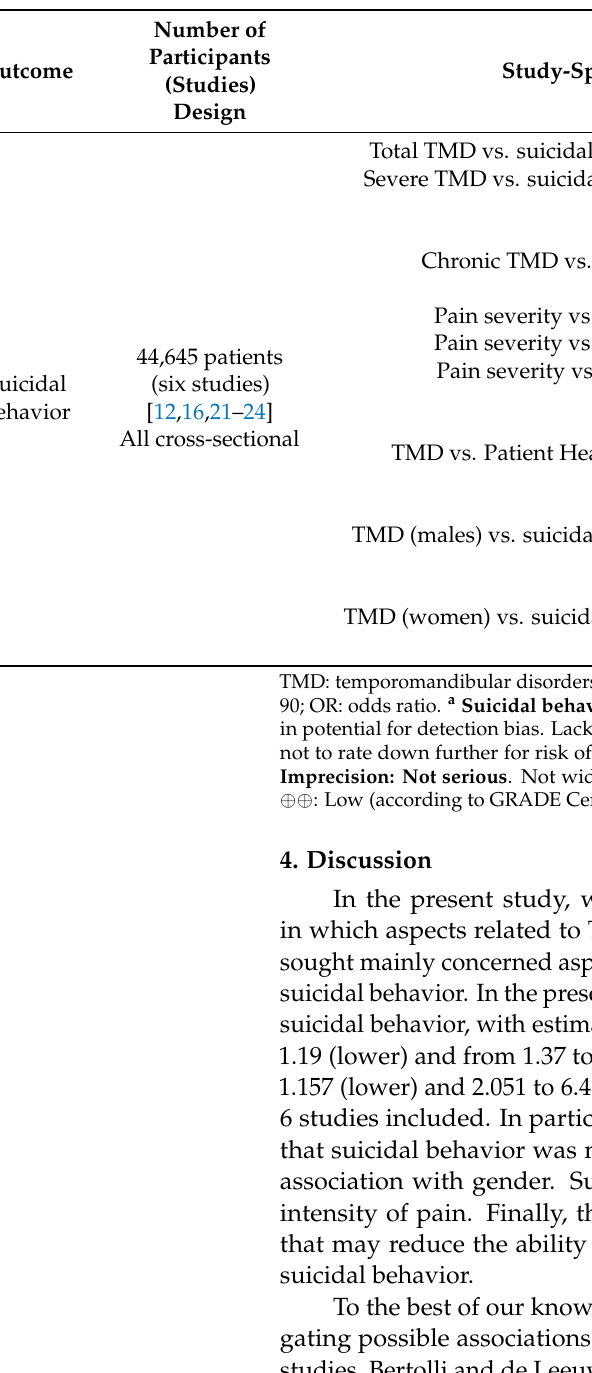
Table 2. GRADE summary of findings on temporomandibular disorders (TMD) associated to suicidal